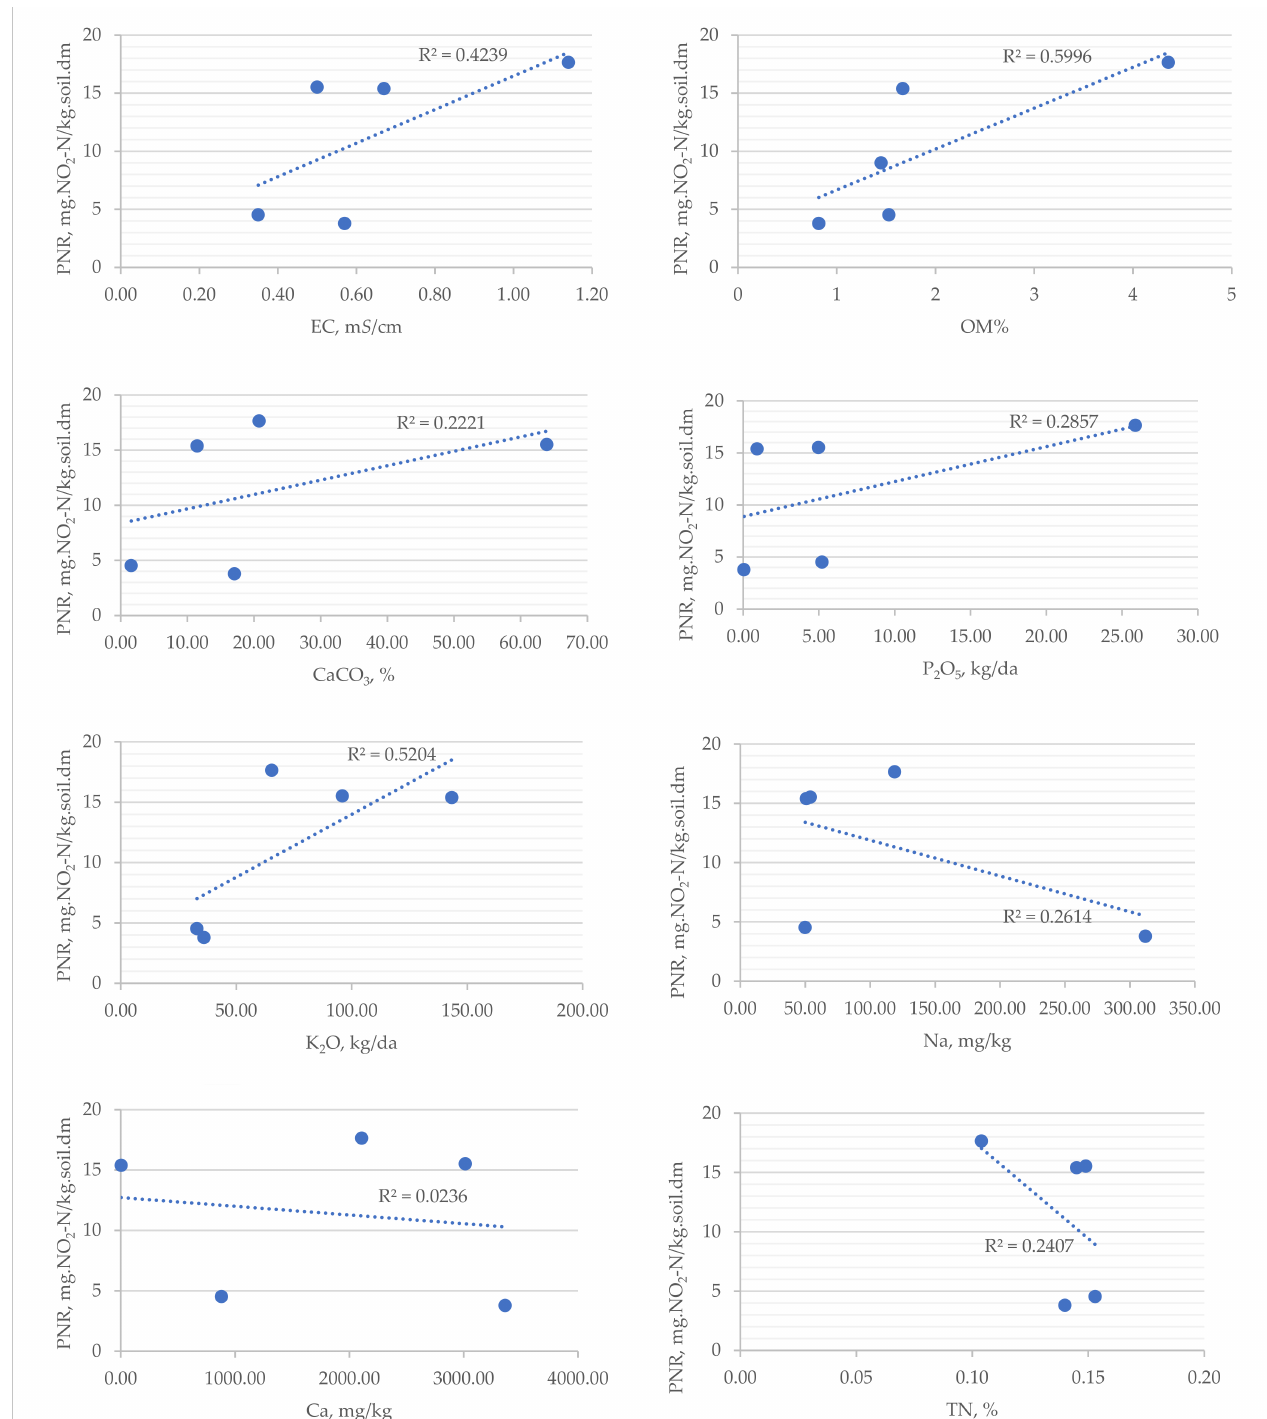
Figure 2. The soil PNRs as functions of soil EC, OM%, CaCO 3 %, P 2 O 5 (kg/da), K 2 O (kg/da), Na (mg/kg), Ca (mg/kg), and